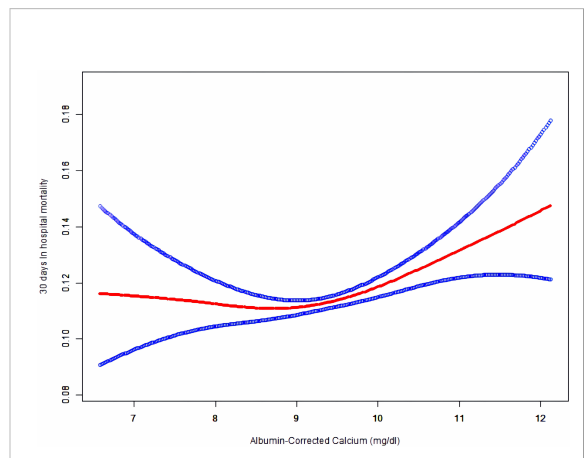
FIGURE 4 The non-linear relationship between albumin-corrected calcium and 30 days In-hospital